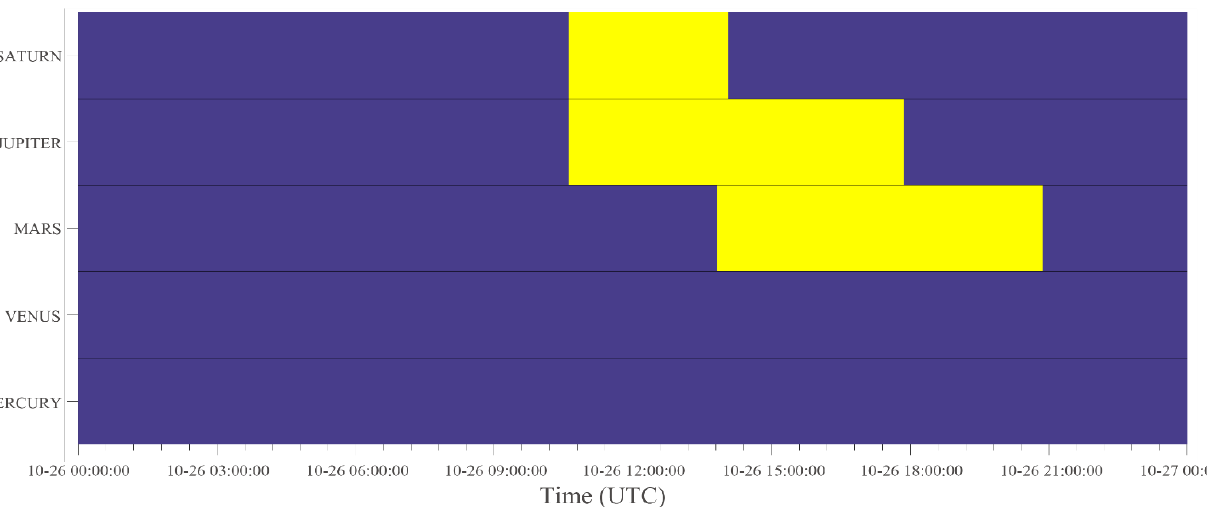
Figure 5. Day view score ( DVS ) of the targets from 1 January 2021 to 31 December 2022. The horizontal axis represents UTC time, and the vertical axis is the DVS . The DVS scatters shows variations of observation quality of each day during this time span. And the holes in between the points indicate unobservable time.